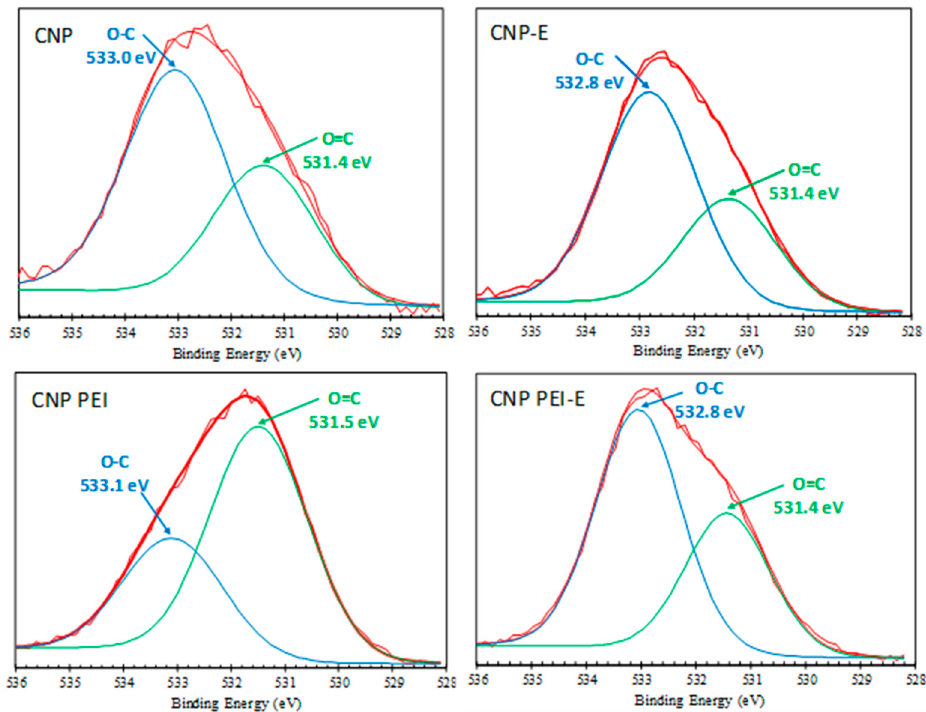
Figure 5. O 1s XPS spectra of CNP, CNP-E, CNP PEI, CNP PEI-E.